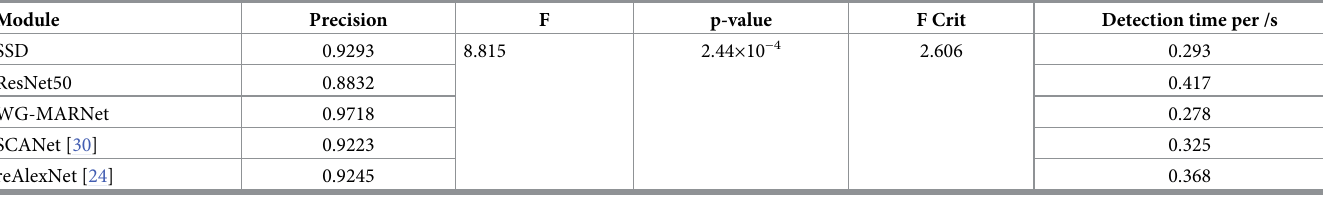
Table 5. Comparison of the detection results for different classification and detection